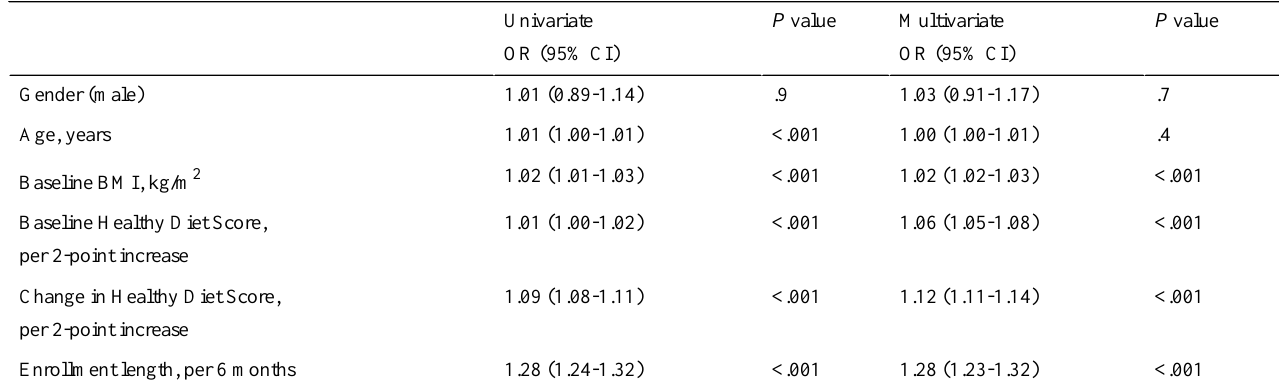
Table 3. Factors contributing to at least 5% weight loss in univariate and multivariate logistic regression